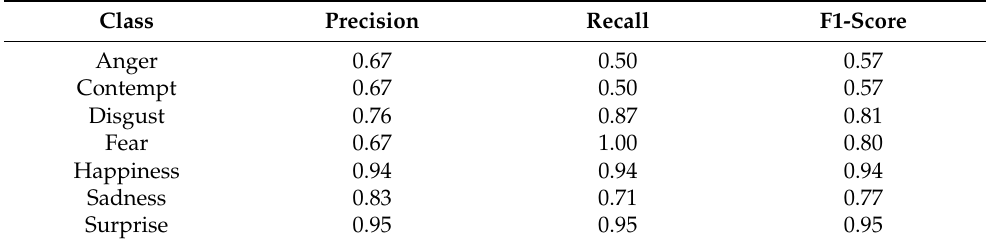
Table 11. SVM training results for iteration 1 of K-fold stratified using dataset2 .